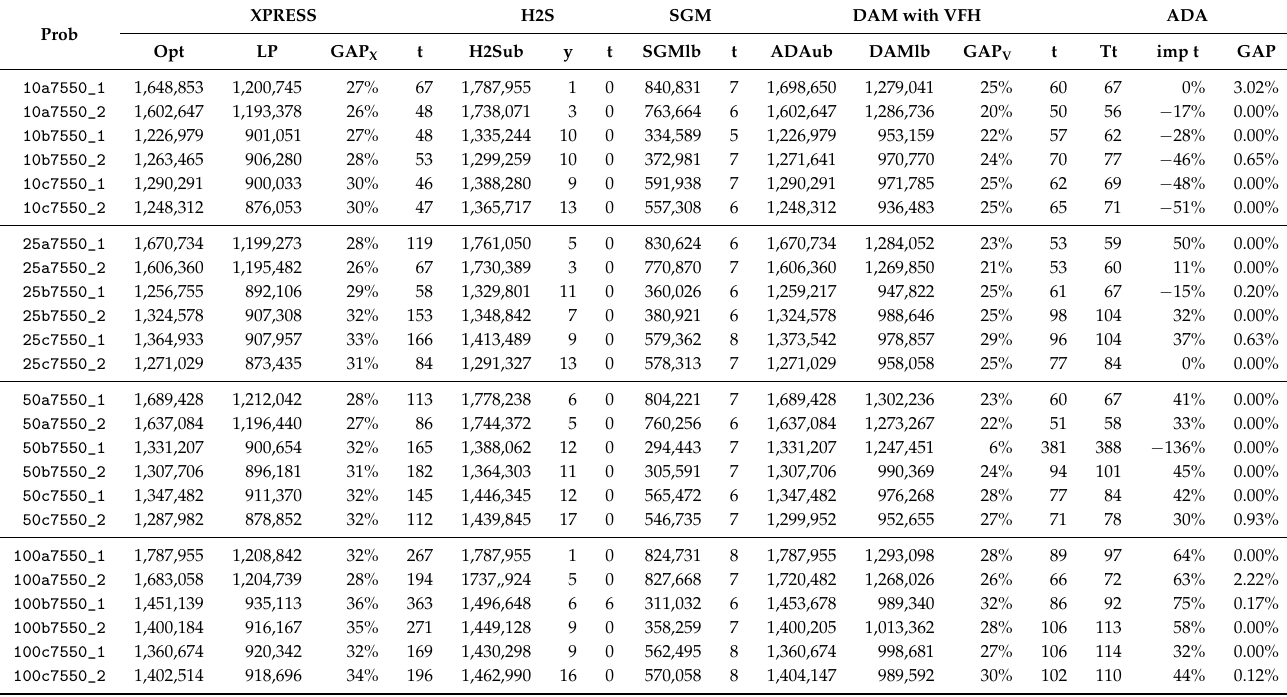
Table 2. ADA algorithm applied to the 2S-SPLPO with two scenarios ( m = 75, n = 50). Source: the authors. Prob